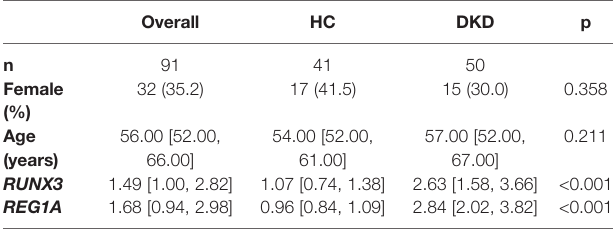
TABLE 2 | Baseline information on diagnostic markers and clinical characteristics in the validation cohort.